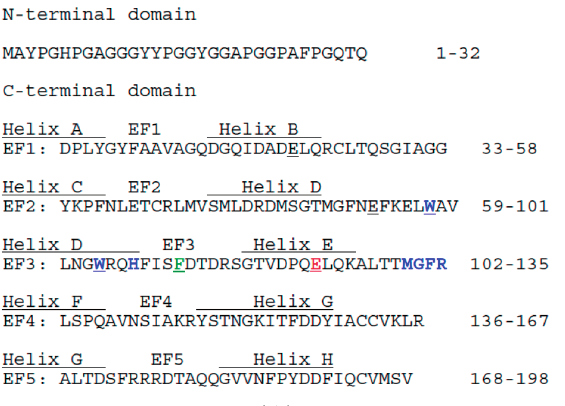
Figure 2. Primary and secondary structure (A) and crystallographic X-ray structure of the human sorcin calcium binding C-terminal domain (B) (PDB: 1JUO). The residues involved in the contact with targets, according to Ilari et al. , 2002, are in bold, colored blue. The residues mutated to analyze the mechanism of activation of sorcin (W99, W105, E53, E94, E124, F112) are underlined. The two monomers in the SCBD dimer are depicted in different shades of gray; the D-helix is indicated in blue; W99 and W105 are blue, F112 is green, E124 is red. Right: Only one SCBD monomer is shown, rotated 90° with respect to the dimer shown on the